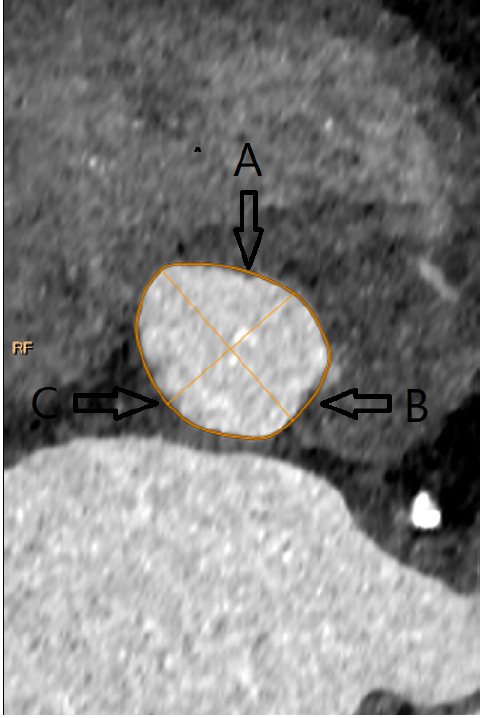
Figure 2. Aortic Annulus with main landmarks. ( A ): Right coronary cusp nadir; ( B ): Left coronary cusp nadir; ( C ): Non-coronary cusp nadir.